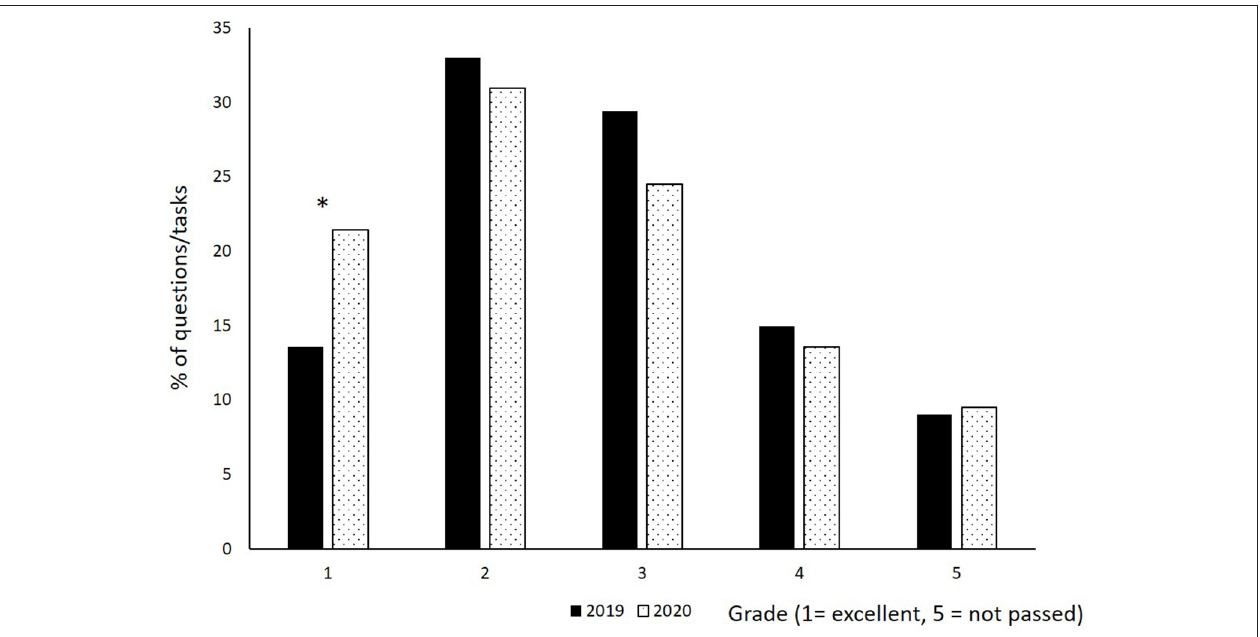
FIGURE 2 | The percentage distribution of exam grades in the state exam in animal nutrition in 2019 after the regular classroom teaching before the pandemic (black columns) and 2020 after the summer term of virtual teaching during the pandemic (white dotted columns). The asterisk (*) marks a significant difference in the odds ratio of a student achieving the respective grade ( p <